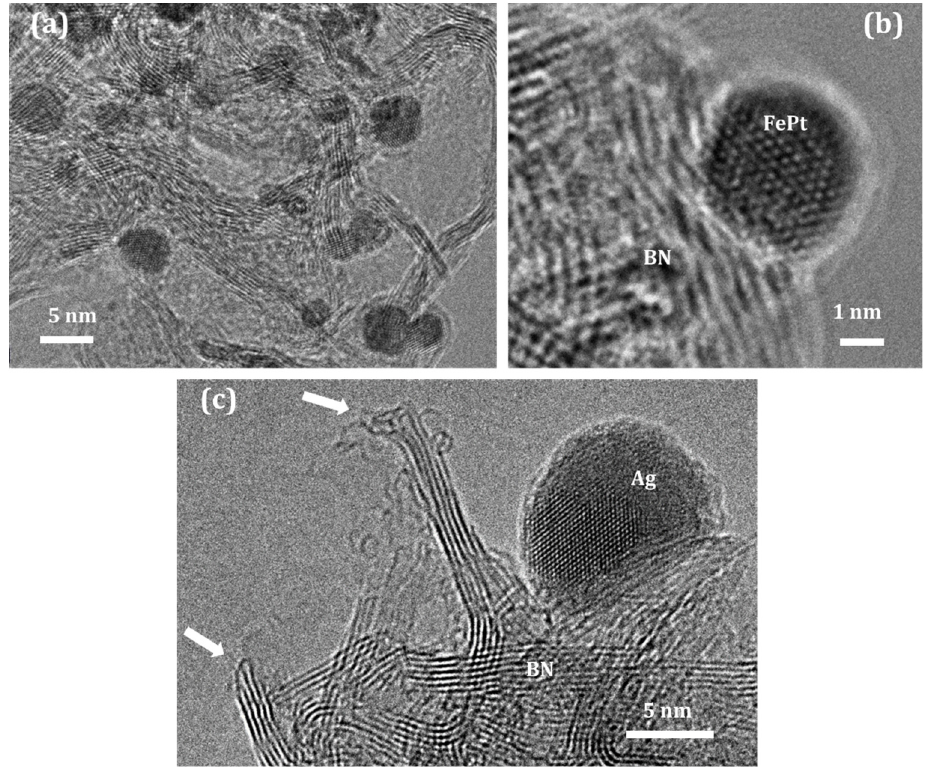
Figure 4. Heterogeneous FePt/ h -BN ( a , b ) and Ag/ h -BN ( c ) catalysts. Arrows show active h -BN edges.